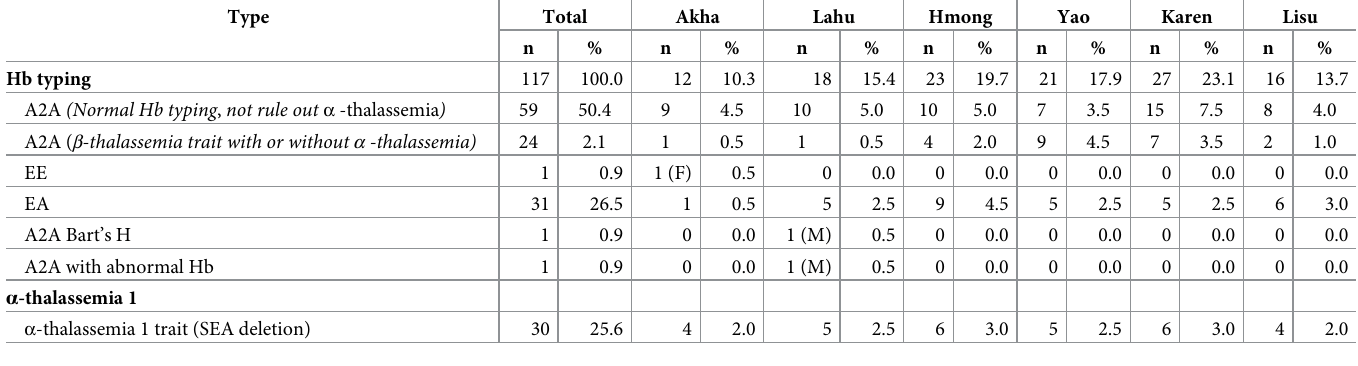
Table 7. Proportions of Hb typing and thalassemia carriers by